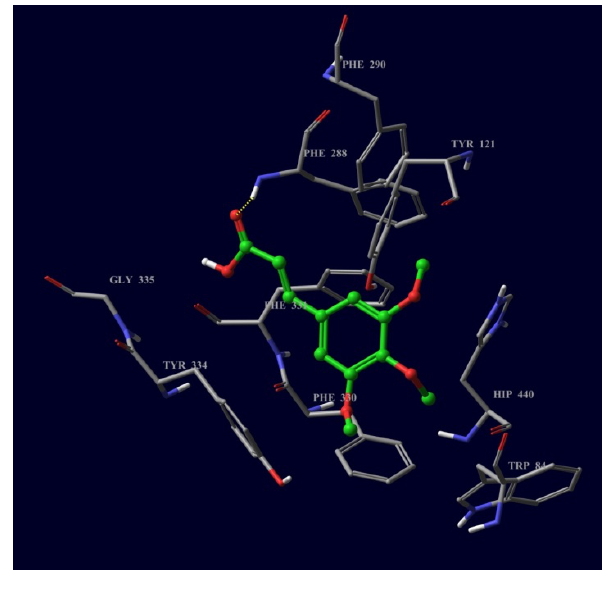
Figure 4. Compound 2 docked into active site of